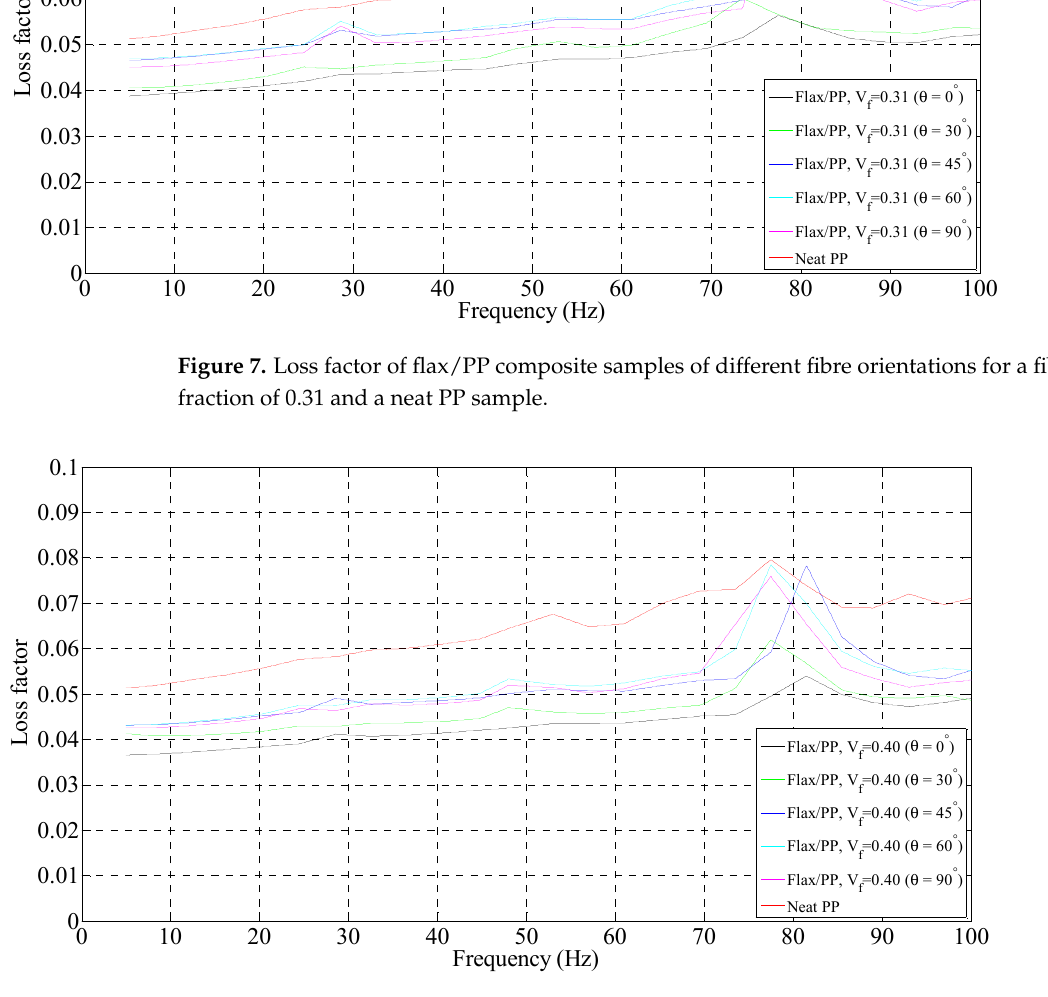
Figure 9. Loss factor of flax/PP composite samples of different fibre orientations for a fibre volume fraction of 0.50 and a neat PP sample.